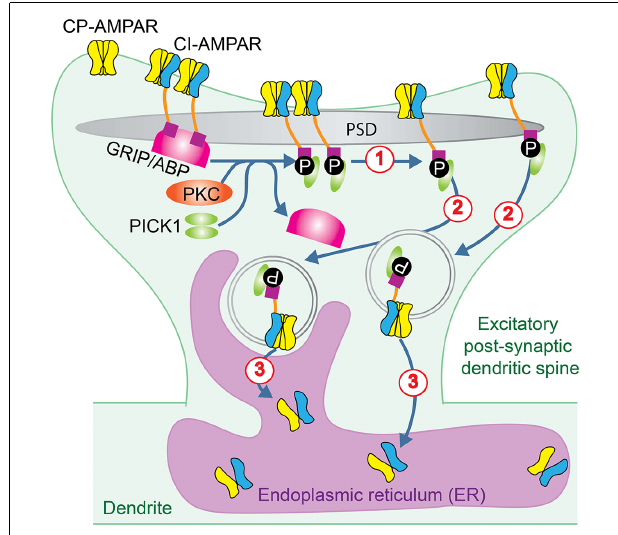
FIGURE 4 | AMPAR trafficking regulated by PKC. PKC phosphorylation of GluA2 subunit in GluA2-containing CI-AMPARs disrupts the association of GRIP/ABP from GluA2 CTD and facilitates its association with PICK1. This rearrangement of CTD binding proteins results in: (1) disruption of AMPAR clusters at the synaptic membrane; (2) internalization of synaptic GluA2 subunits, and (3) restriction of GluA2 subunits to the intracellular pool in the